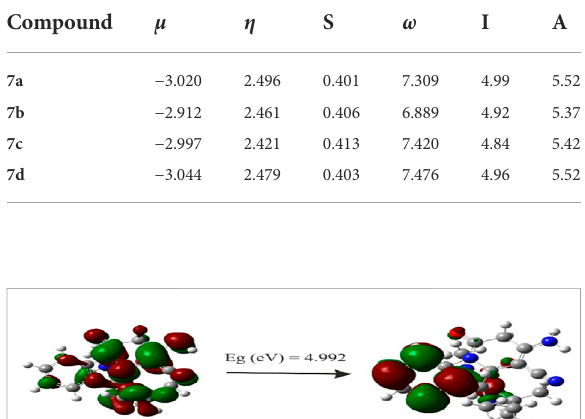
TABLE 7 Molecular descriptor results.